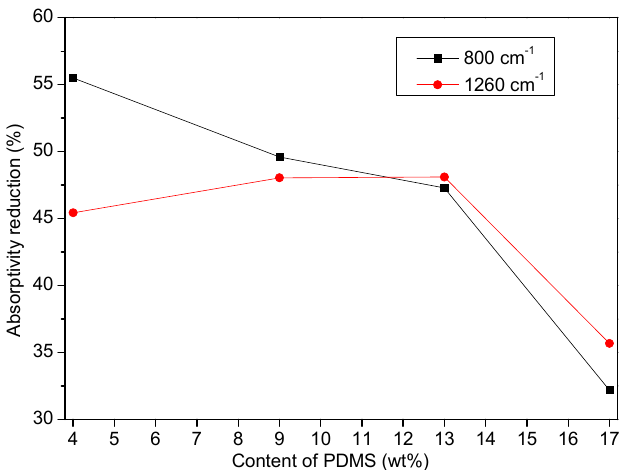
Figure 11. Infrared absorptivity reduction at 800 and 1260 cm − 1 of samples containing PDMS after